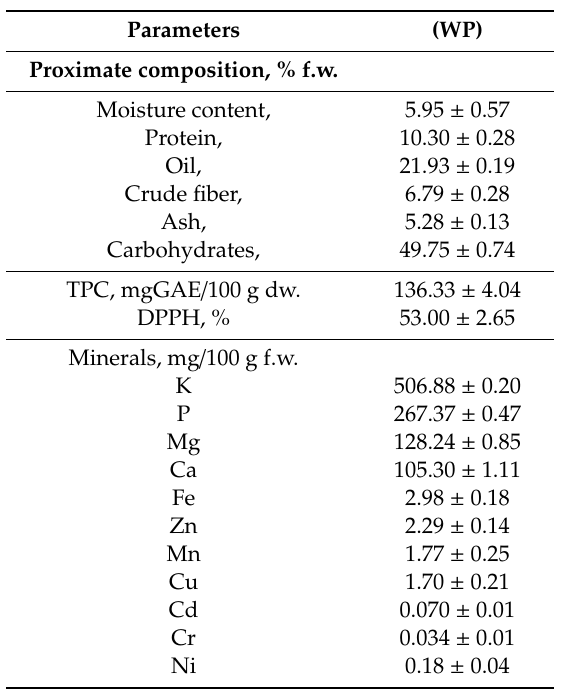
Table 1. Chemical composition and mineral content of walnut oilcake